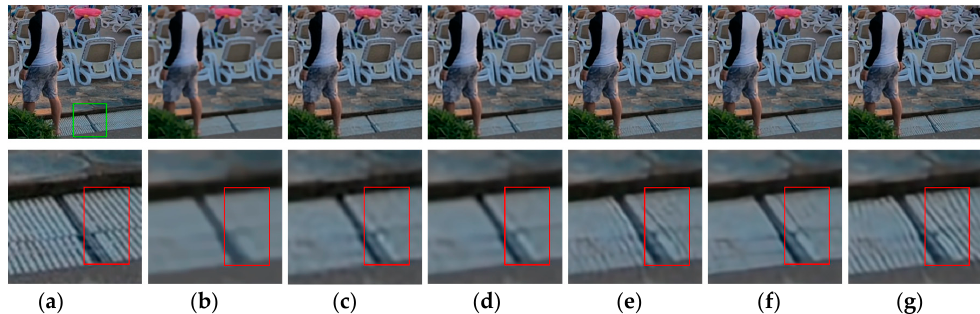
Figure 14. Deblurred results for test image with 17 × 17 Gaussian blur kernel of deviation 2.2. The first row shows the sharp image and deblurred images for the evaluated methods. The second row shows the enlarged views of the region marked with the green box in the original image and the deblurred images.